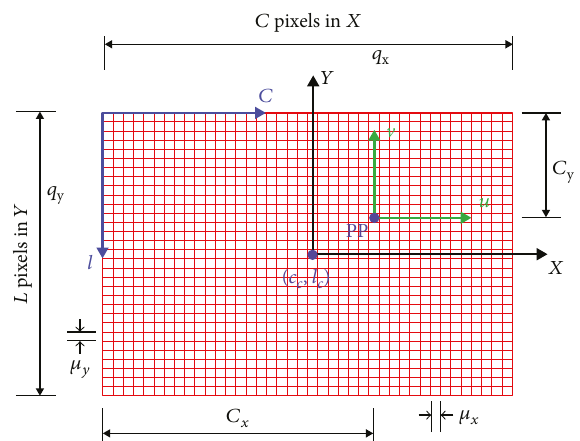
Figure 16: Reference systems and parameters in the image representation of a camera. x and y : the coordinates in the image system with origin in the center pixel, in pixels; c c and l c : the column and center pixel lines; u and v : the coordinates in the image system originating from the main point, in pixels; PP: the principal point of collimation, point of intersection of the optical axis with the sensor; c and l : the axes of the column-row reference system of the image, originating from the upper left pixel; c x and c y : the principal point lags, in pixels, measured in the directions relative to the upper left pixel; μ x and μ y : the pixel dimensions in the x and y directions; q x and q y : the dimensions of the sensor in the x and y directions; C and L : the number of columns and rows in the